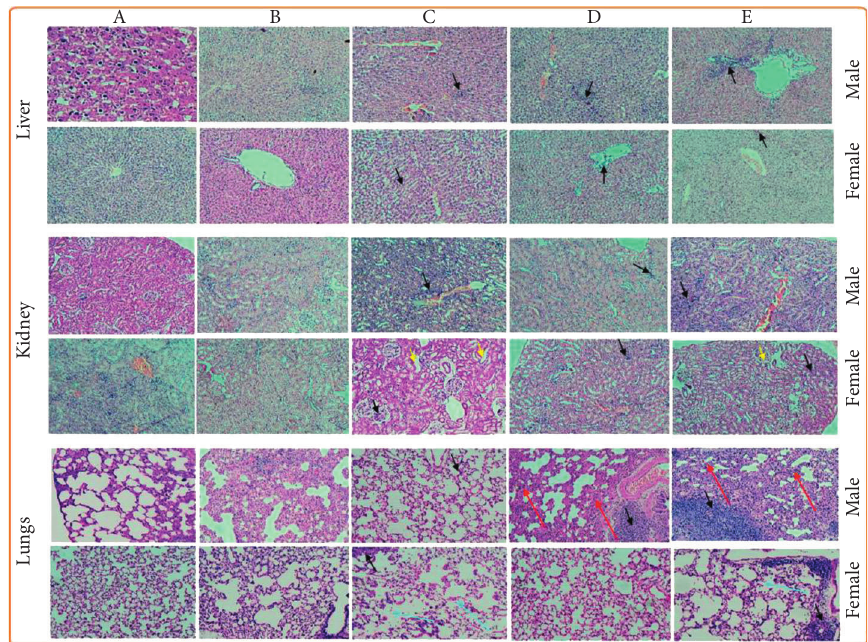
Figure 2: Photomicrographs of the liver, kidney and lungs of male and female rats in subacute inhalation toxicity of AND-2-HyP- β -CYD complex: (a) normal control, (b) vehicle control (citrate buffer, pH 6.5), (c) low dose (0.5mg/L/4 h), (d) medium dose (1mg/L/4 h), and (e) high dose (1.66mg/L/4 h). Magnification of 40x was used. Black arrow indicates the presence of inflammation in the lungs, liver, and kidney of both the sexes at low, medium, and high doses. Yellow arrow denotes the degenerative changes in the kidney of medium and highest doses. Red arrows in the lungs of male rats at mid and high doses show sign of decongestion, whereas blue arrows in the lungs of female rats at low and high doses reveal degenerative changes in perialveolar